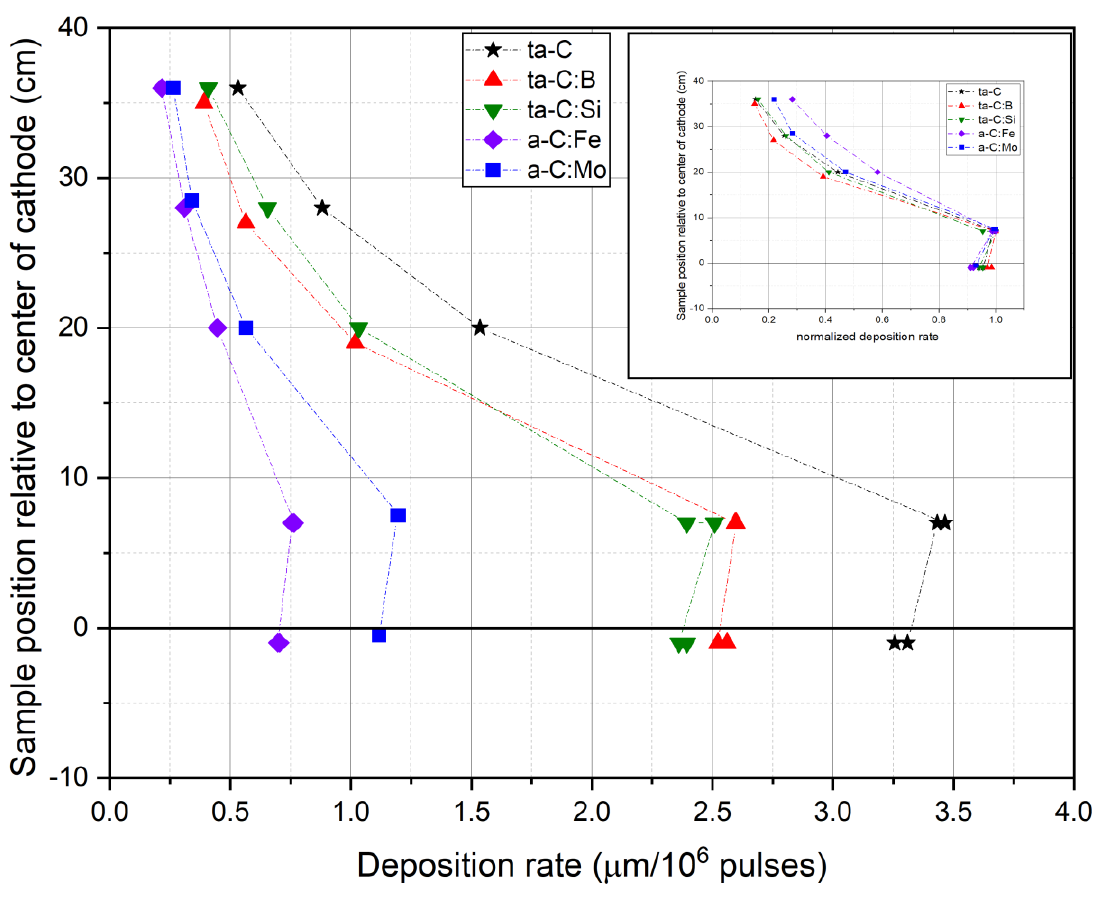
Figure 6. Absolute and normalized (inlay) deposition rates of different sample positions relative to the cathode